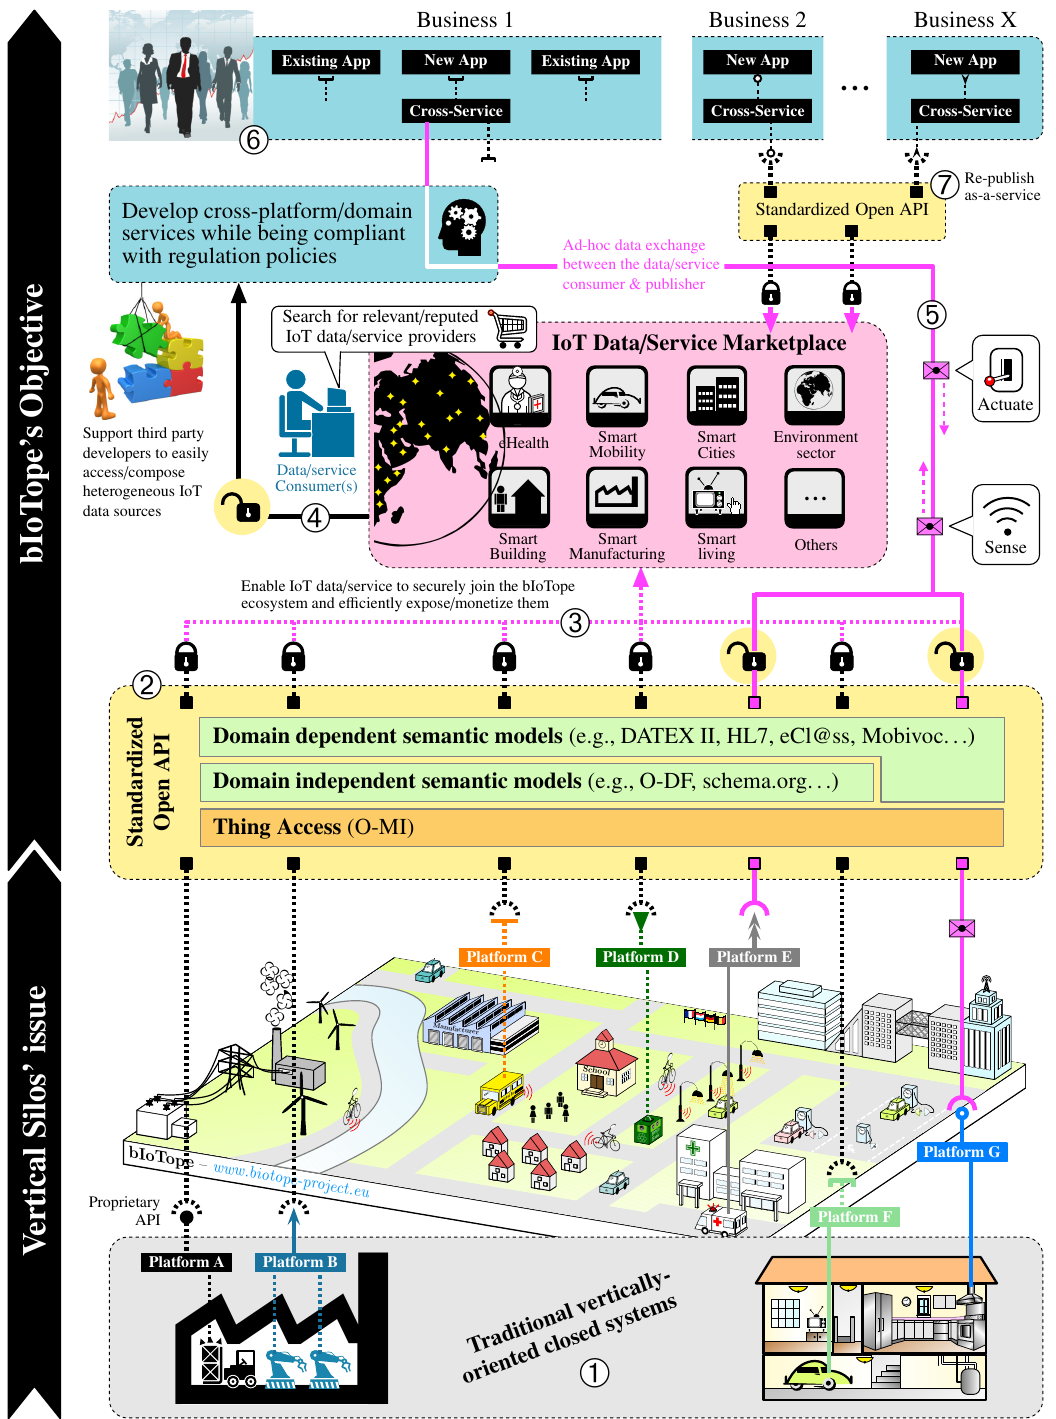
Figure 3. Overview of the building blocks of the bIoTope ecosystem based on four-layer structure given in Figure 2 (the color set introduced for each layer having been